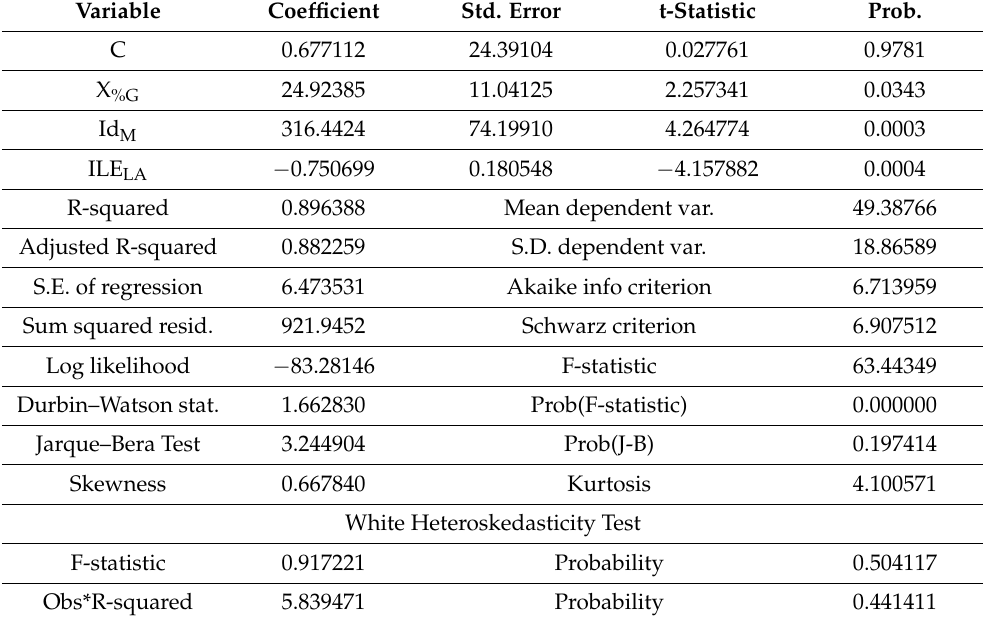
Table 2. S FDI_in(%GDP) model by X %G , Id M and ILE LA for